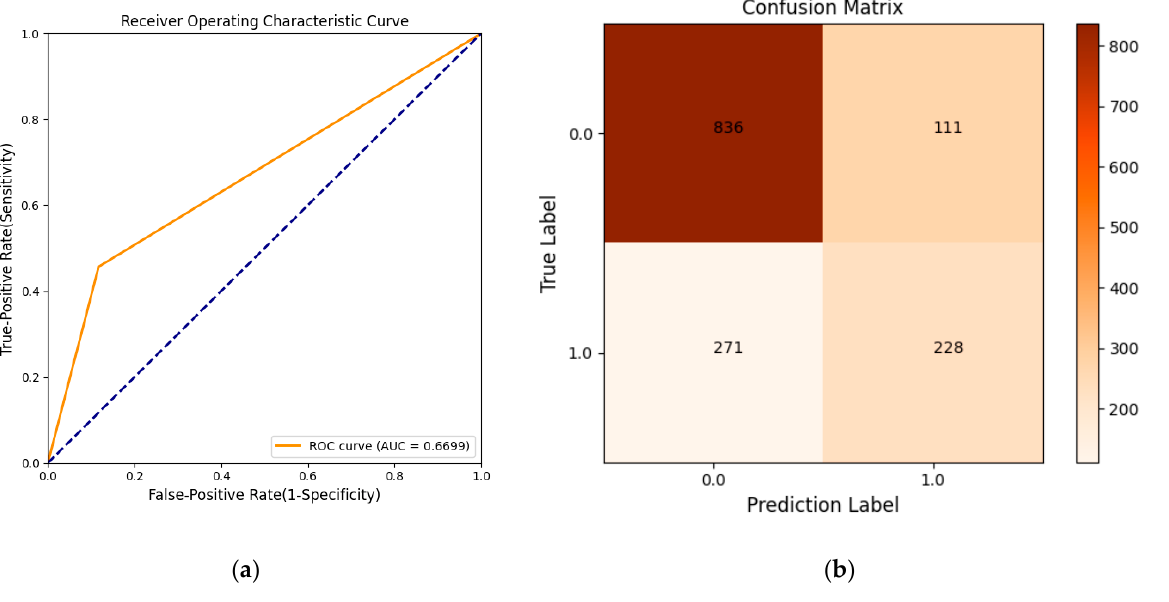
Figure 4. Disease occurrence prediction model classification indicators for hot pepper powdery mildew. ( a ) ROC curve; and ( b ) confusion matrix.